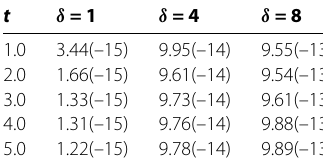
Table 3 Example 1: Case 1.1(b): Maximum absolute errors